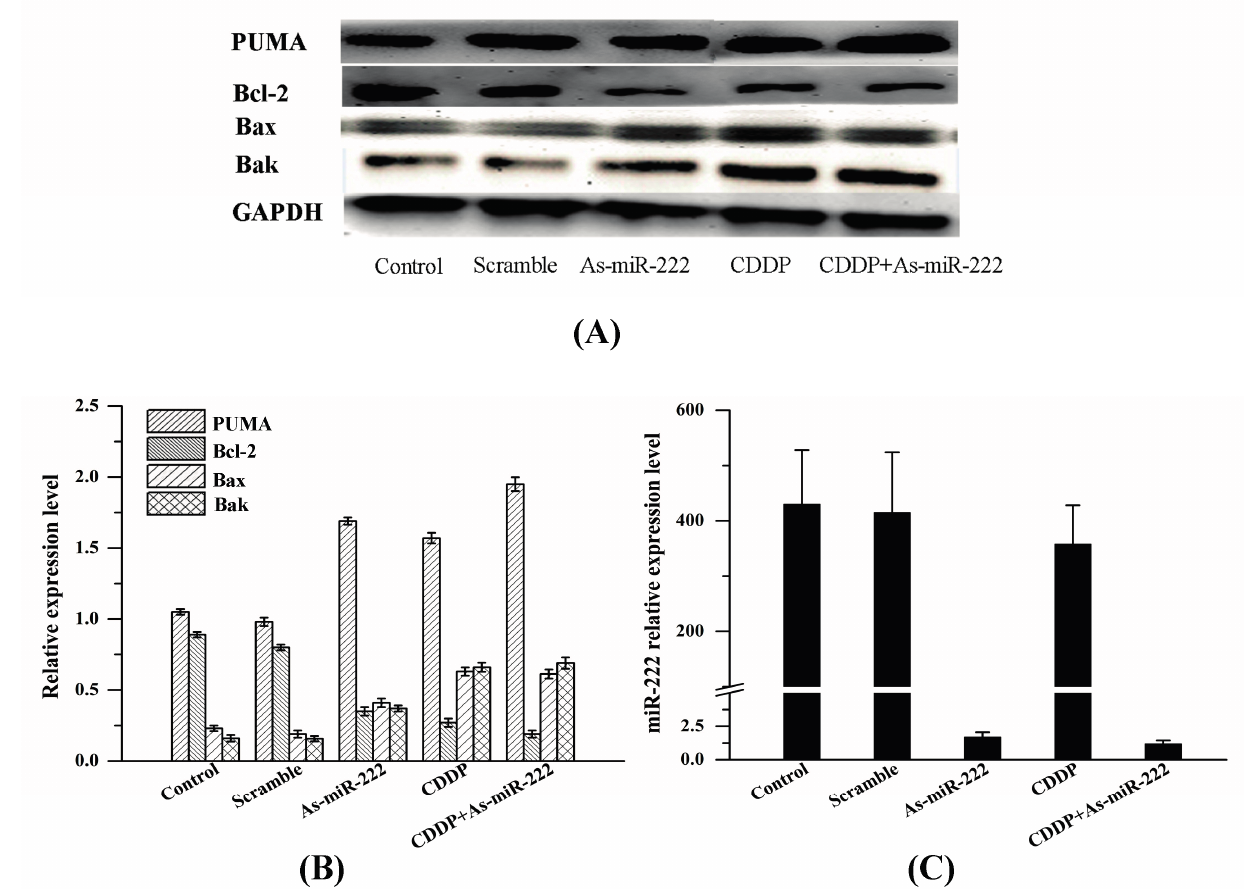
Figure 2. Expression of PUMA, Bcl-2, Bax and Bak in UM1 cells with treatment of As-miR-222 and CDDP. ( A ) As determined by Western blot analysis, PUMA, Bax and Bak were observed to be overexpressed in the CDDP, As-miR-222 and As-miR-222/CDDP groups. In contrast, Bcl-2 exhibited an opposite trend; ( B ) Relative expressions of PUMA, Bcl-2, Bax and Bak were quantified by Image J Instrument software after normalization with the density of GAPDH; and ( C ) miR-222 expression as control detected by